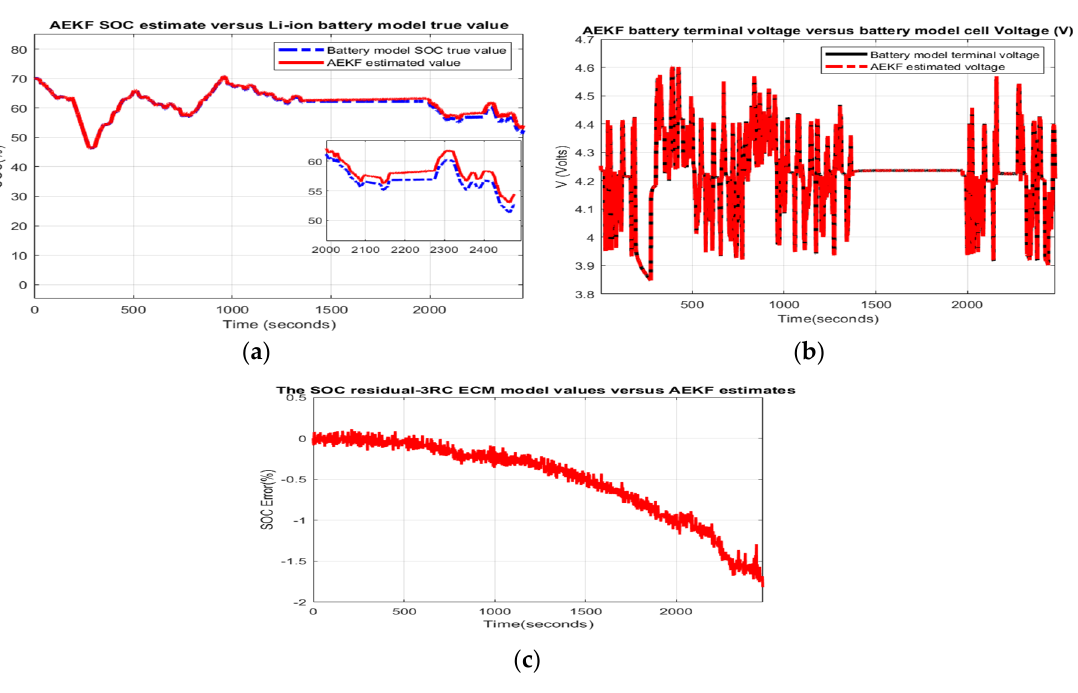
Figure A12. The MATLAB simulation results for Simulink Simscape Li-ion battery. ( a ) The AEKF SOC value versus battery model SOC true value; ( b ) The AEKF terminal output voltage versus battery model terminal output voltage true value; ( c ) The SOC residual.